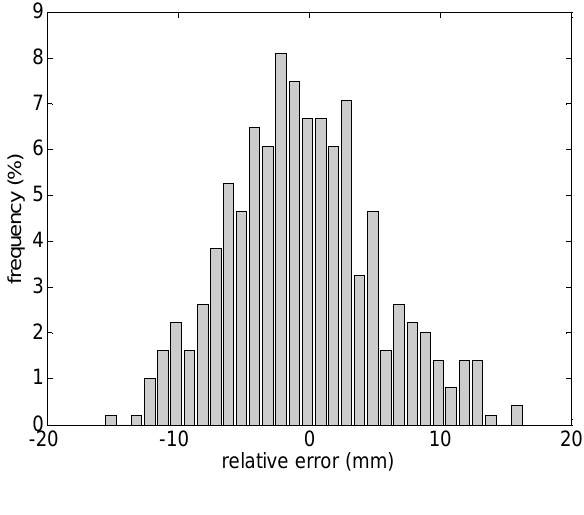
Figure 2. Histogram of the error in the distance measured: target at 8 m, angle